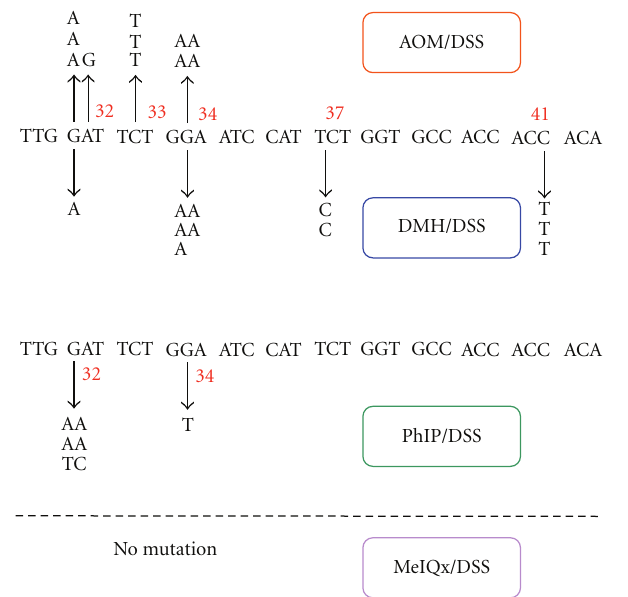
Figure 15: Mutations in the GSK-3 β phosphorylation consensus motif of the β - catenin gene in adenocarcinomas of mice induced by AOM/DSS, DMH/DSS, PhIP/DSS, and 2-amino-3,8-dimethylimidazo-[4,5- f ]-quinoxaline (MeIQx)/DSS. PhIP and MeIQx are heterocyclic